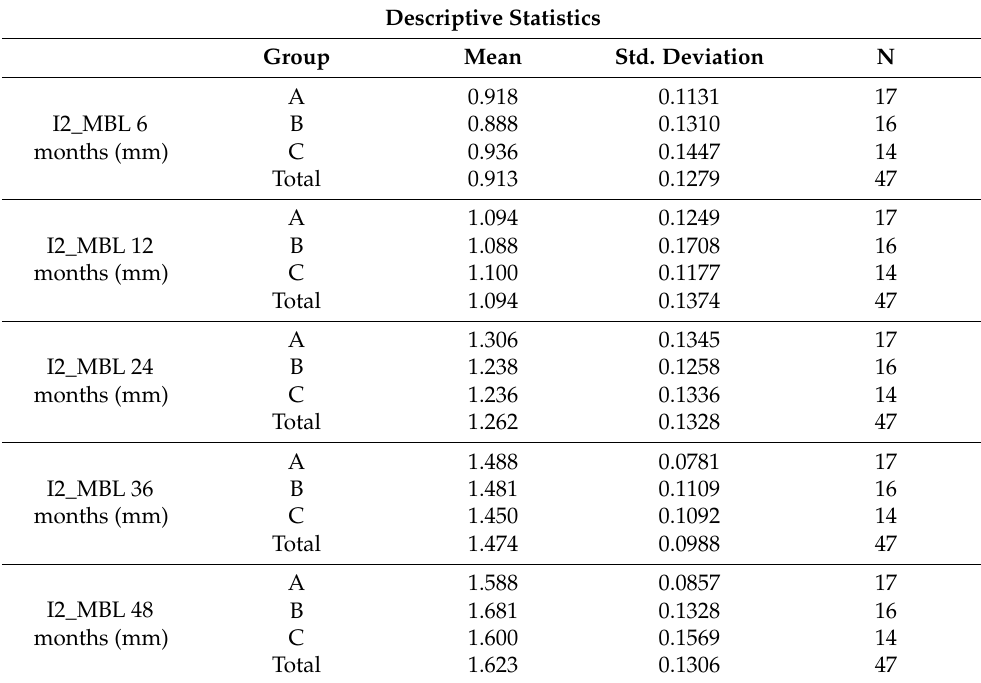
Table 6. Average marginal bone loss (millimeters) of distal implants (I2) observed during